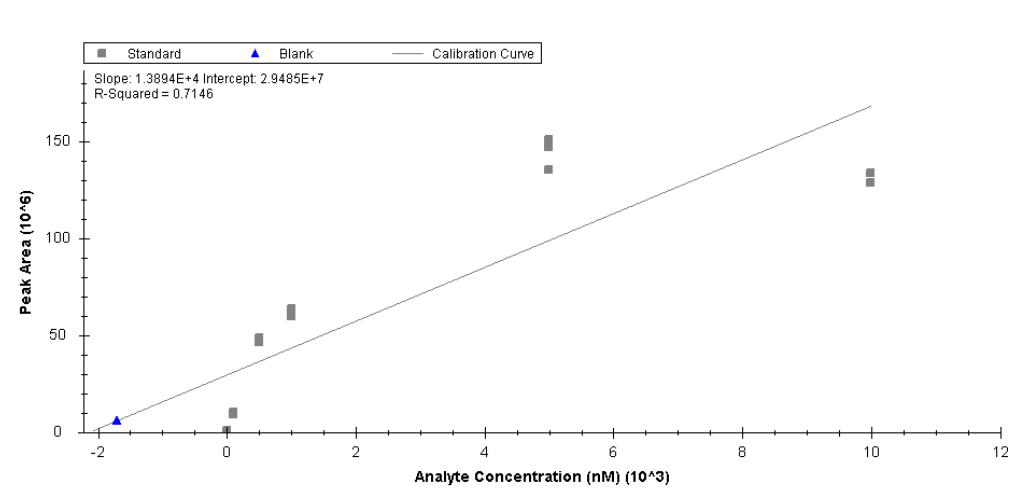
Table S2. Regulated pathways comparing MSC and adipocytes. Significantly regulated ( p -value <